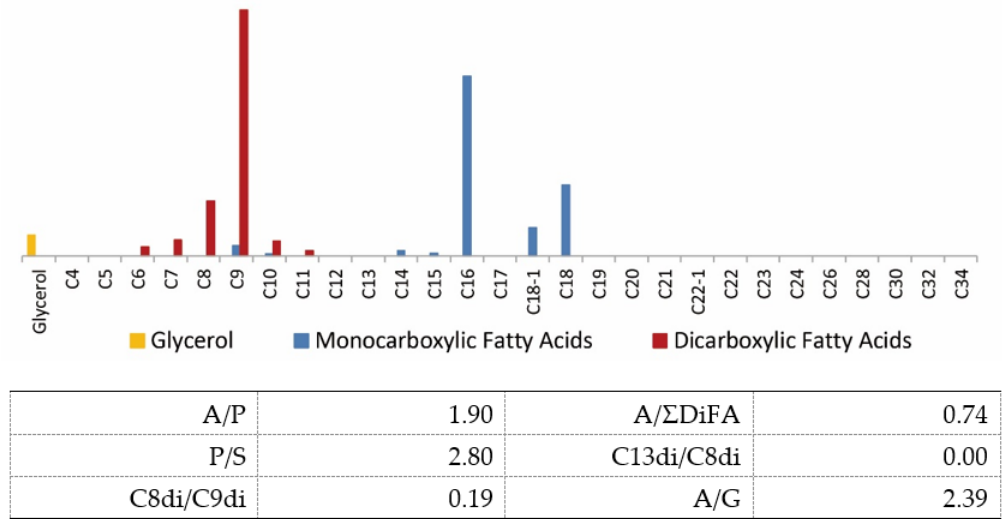
Figure 7. Fatty acid profile detected in sample from Cave N(a) (BMM035). AMDIS Excel data from Meth Prep. Azelaic = C9di, Sebacic = C8di, DiFa = dicarboxylic fatty acids indicate oxidation, C18-1 = oleic acid.